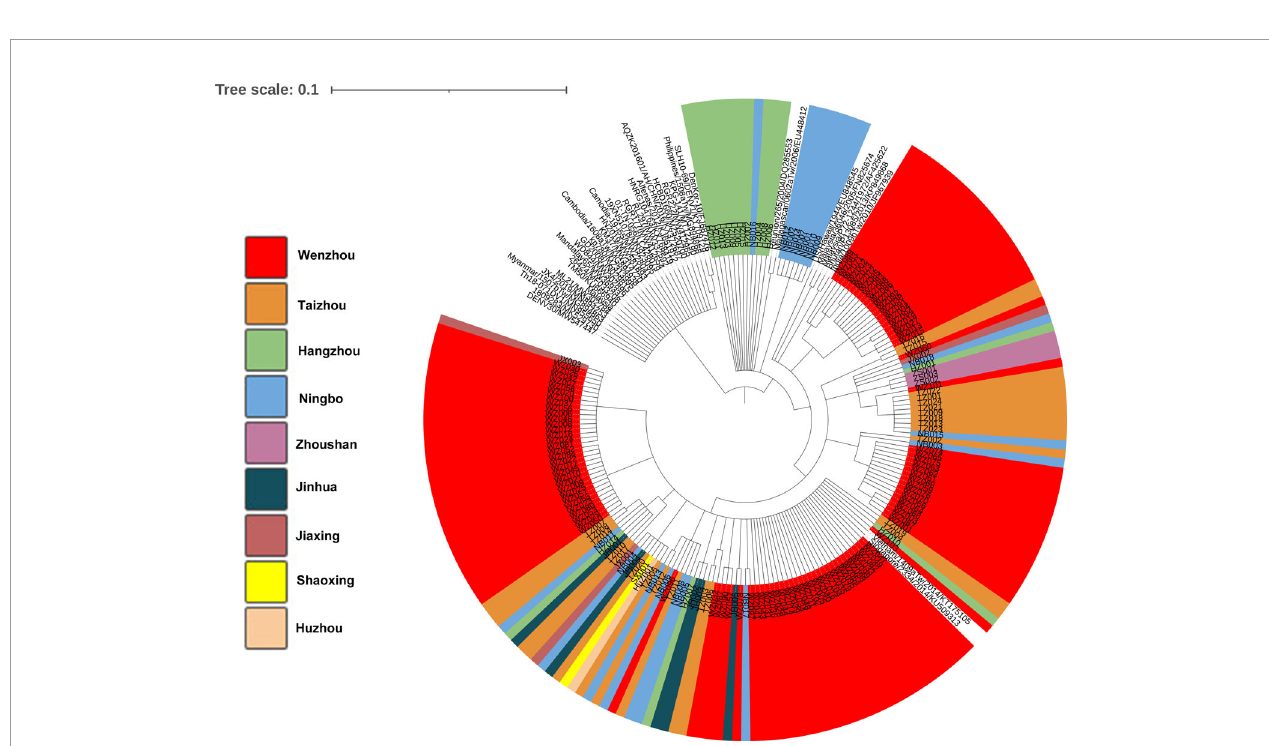
FIGURE 3 | Phylogenetic analysis of isolated DENV-1 based on the E gene. Phylogenetic tree was constructed on the basis of whole nucleotide sequences of the E protein gene of DENV-1 showing the relationship of 174 DENV-1 isolated and 39 of reference sequences.